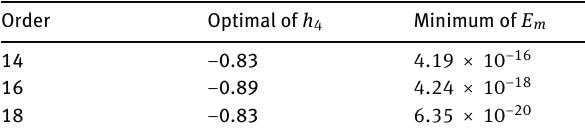
Table 5: Optimal value of h 4 at different order of